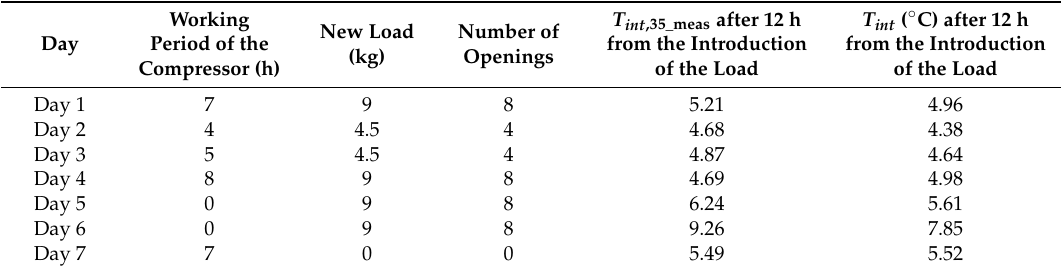
Table 5. Comparison of the measured calculated and the measured average air temperature after 12 h from the introduction of the load.